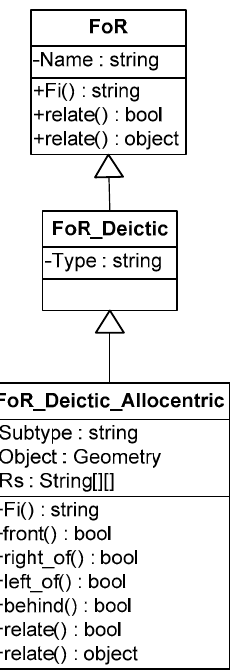
Figure 9. The UML diagram of the deictic-allocentric frame of reference.